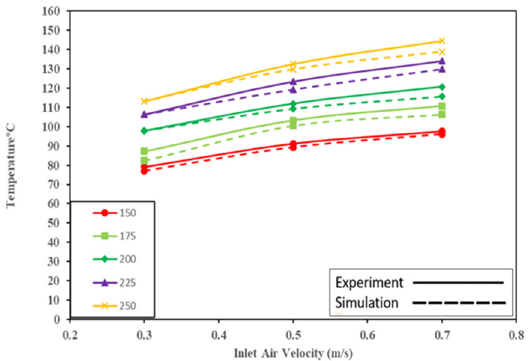
Figure 9. Outlet air temperature comparison for experimental and numerical analysis with different input velocities and temperatures of air.